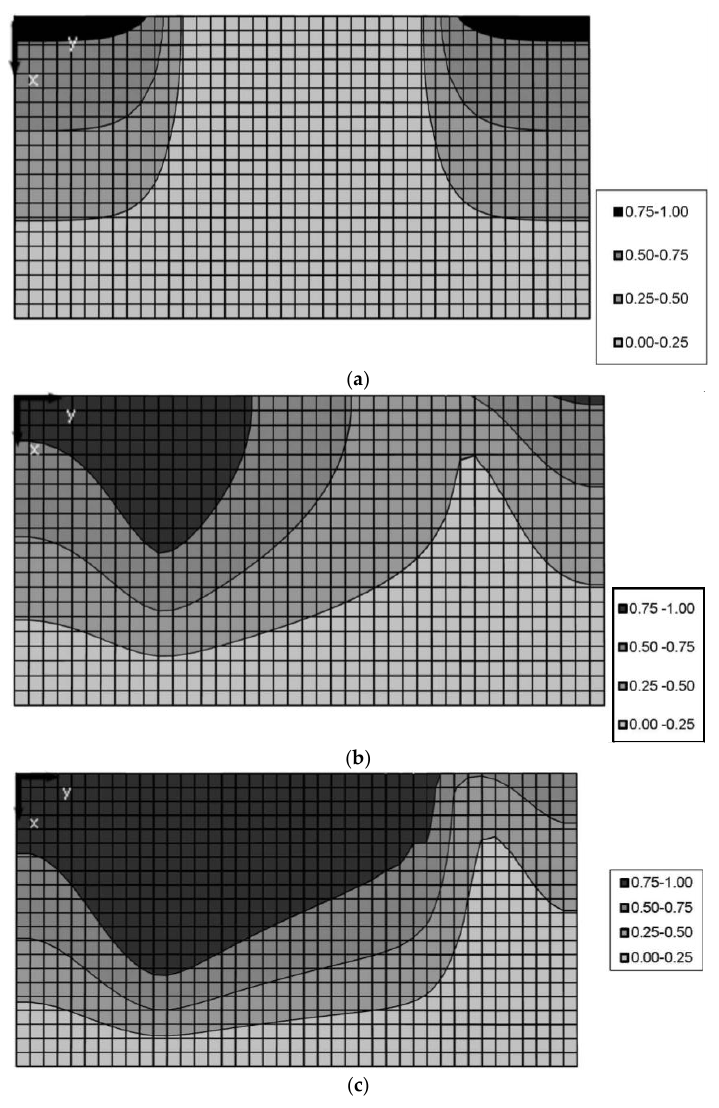
Figure 3. Reduced composition field in the control volume as a function of the velocity field, as summarized by the Peclet number Pe y . B/D = 1; H/D = 0.1; x A1 = x A2 ; limit current: ( a ) Pe y = 0; ( b ) Pe y = 100; and ( c ) Pe y = 300.